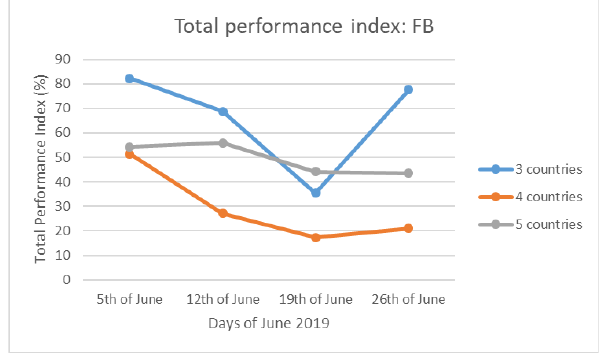
Figure 12. Total performance index calculated for FB